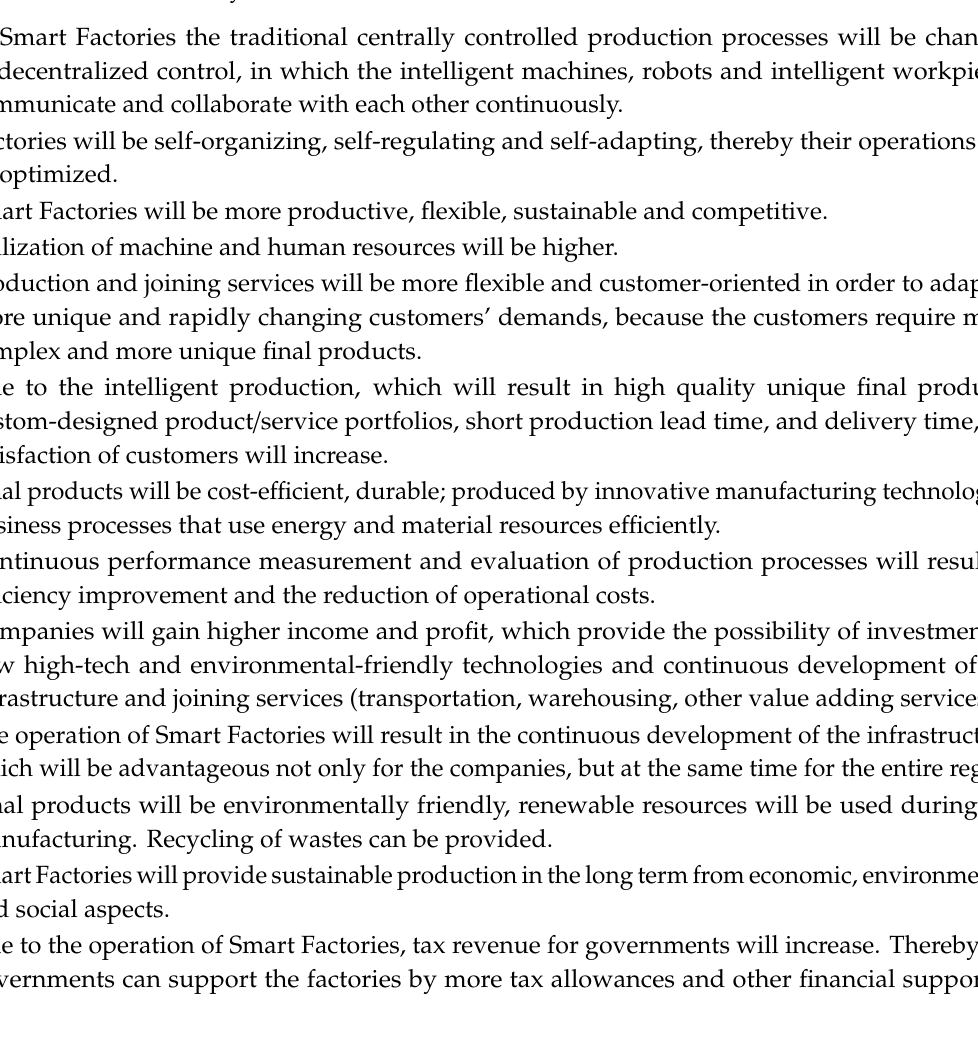
Table 1. Comparison of the traditional factory and Smart Factory.